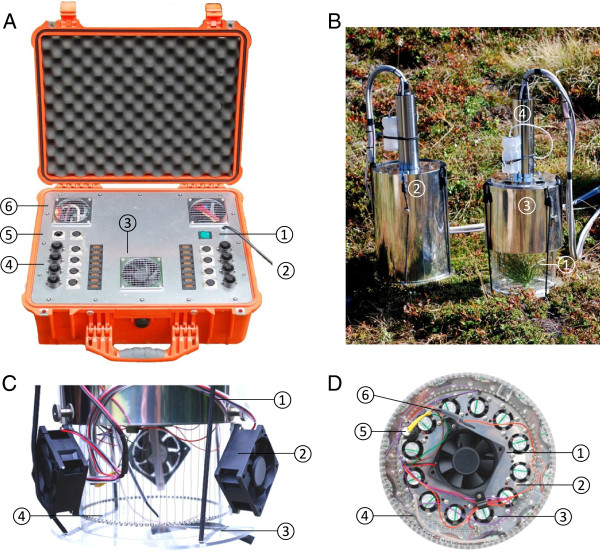
Major components of the heat tolerance testing system. A. The mobile supply unit is housed in a rugged and weather - proof enclosure. (1) Main switch, (2) power supply cable, (3) ventilation hole with fan, (4) connection panel for the eight exposure chambers, (5) RJ45 network port for connecting the notebook from which the complete system can be controlled, (6) venting hole (passive). B. Two exposure chambers in upright position during a controlled heat exposure. Heat exposure of a small Pinus cembra L. seedling (1) in dark - mode (2) and under natural solar irradiation (3). The handle (4) contains a hose pump and an electronic interface for controlling temperature and humidity inside the exposure chamber. C. Side view of an exposure chamber. (1) Sunscreen, (2) external fan for cooling purposes, (3) transparent bottom with opening slit, (4) heating wires preventing condensation inside the chamber. D. View into the inside of the heat exposure chamber. The main fan (1) transports air from the exposure room to the heating and humidifying system behind the separating plate (2) from where it is delivered back by 12 small fans (3). (4) Mobile temperature sensor, (5) humidity sensor (heated), (6) stationary temperature sensor.